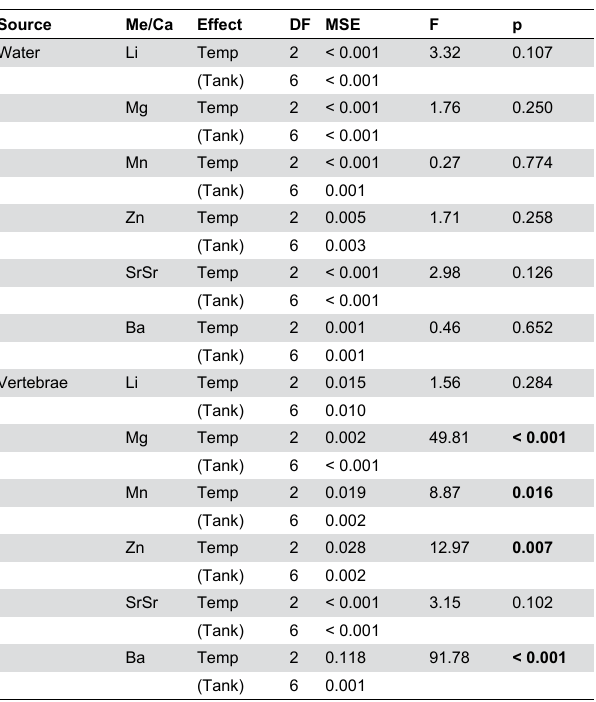
Significant p-values are indicated by bold font. Data were log 10 -transformed prior to analysis. doi: